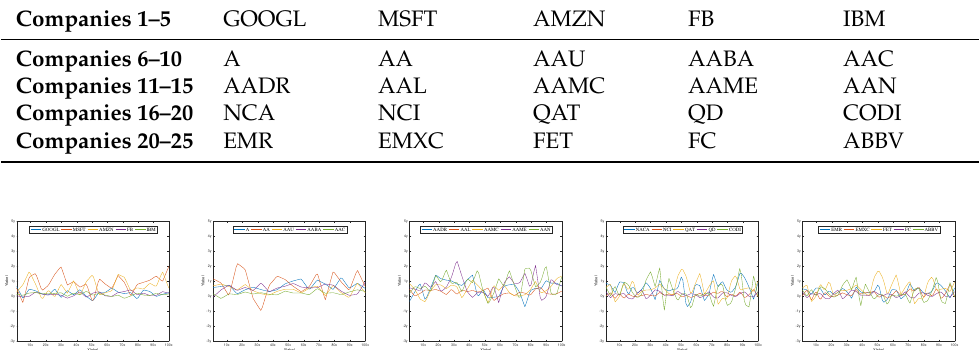
Table 2. NASDAQ Symbols of The Stock Companies In Portfolio Selection.